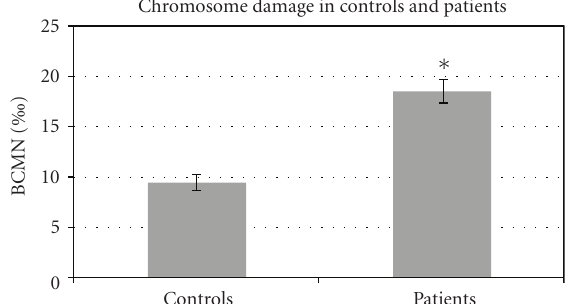
Figure 1: Frequency of BCMN in untreated BC women and healthy controls. A total of one thousand binucleated cells were analyzed for MN count in each of 62 BC patients and 62 age-matched controls. Bars represent standard error of mean; ∗ P < . 001 significantly di ff erent from control group.